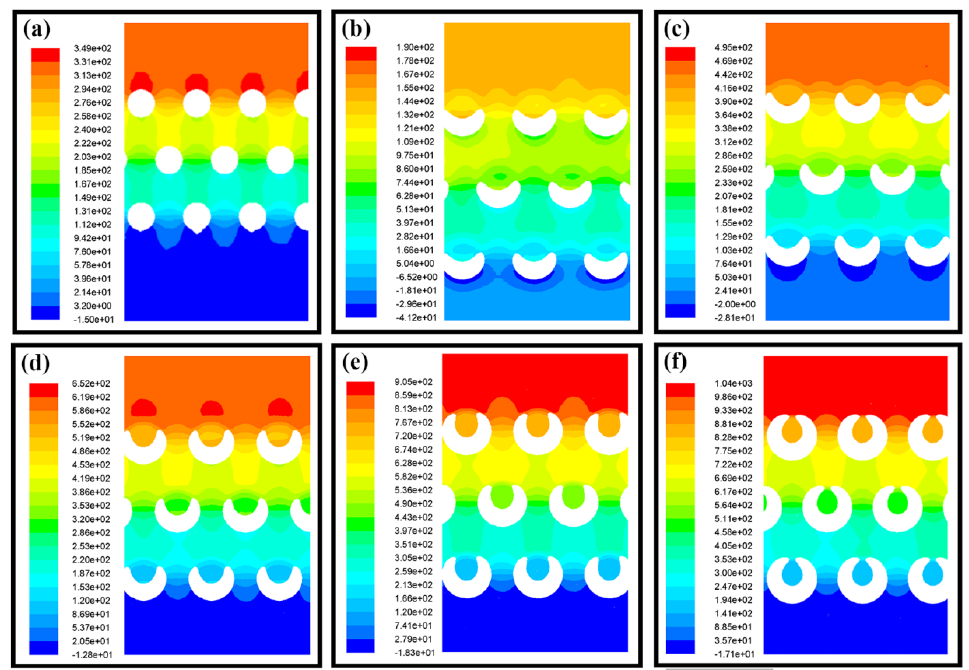
Figure 3. The static pressure distribution of the airflow inside different nanofibrous membrane layers. ( a ) cylindrical nanofiber with a diameter of 2.0 µm; ( b – f ) spiral nanofibers with a diameter of 2.0 µm. The pitch was 4.0 µm, 3.5 µm, 3.0 µm, 2.5 µm and 2.1 µm in ( b – f ), respectively.